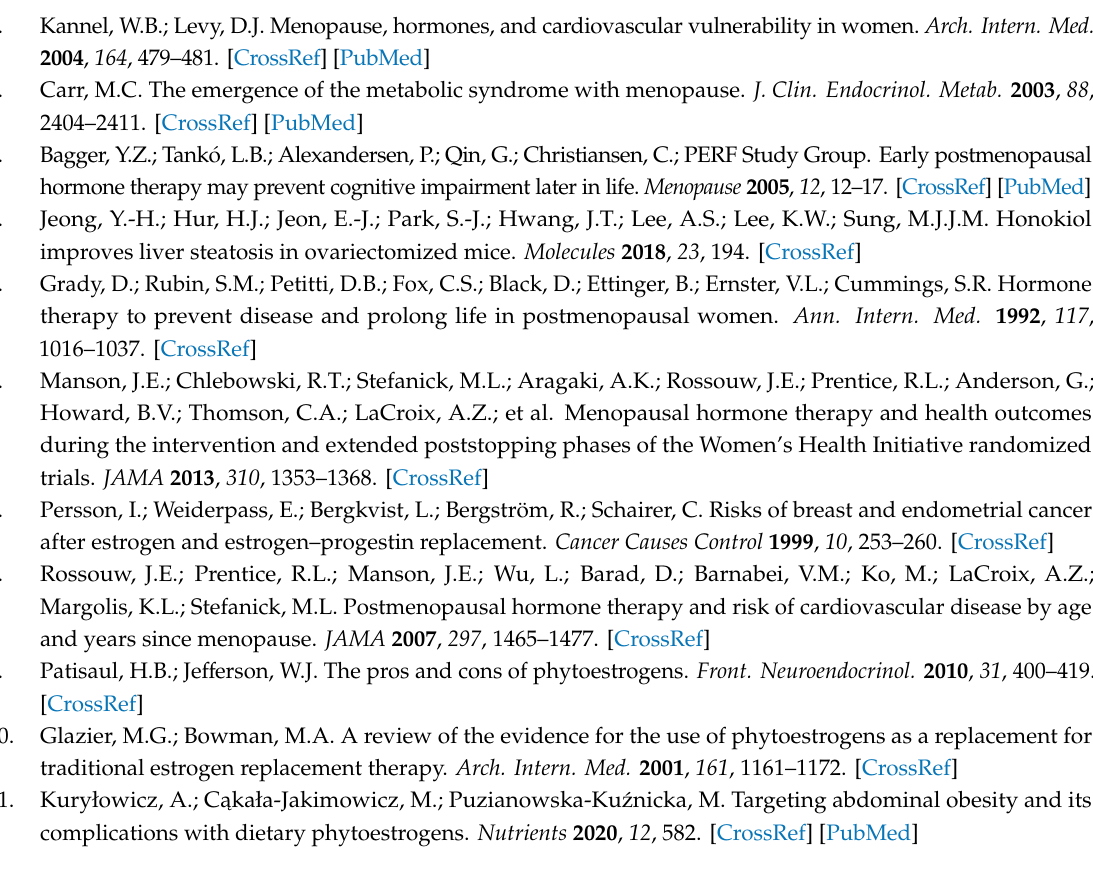
Table S1: compositions of experimental diets; Table S2: liver- and fat-tissue weights of rats; Table S3: expression of fatty acid β -oxidation-related genes and adiponectin